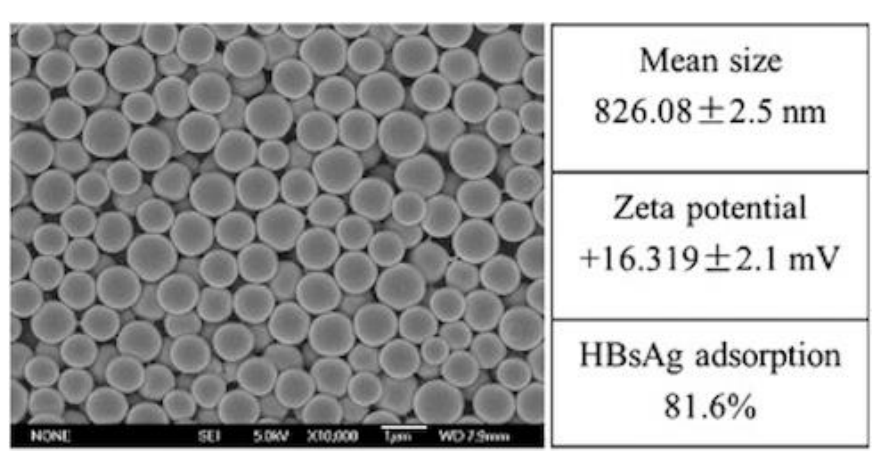
Figure 12. Scanning electron micrographs and dynamic light scattering Zetasizer analysis were used to characterize PLA microparticles (MP) modified by cationic chitosan chloride surface coating. Antigen adsorption was calculated by comparing the amount of antigen in supernatants after centrifugation with total input antigen (protein concentration was analytically determined). The load of HBsAg/particles was 3.2 (μg/mg). Reprinted from [147] with permission from Elsevier, Copyright 2014.